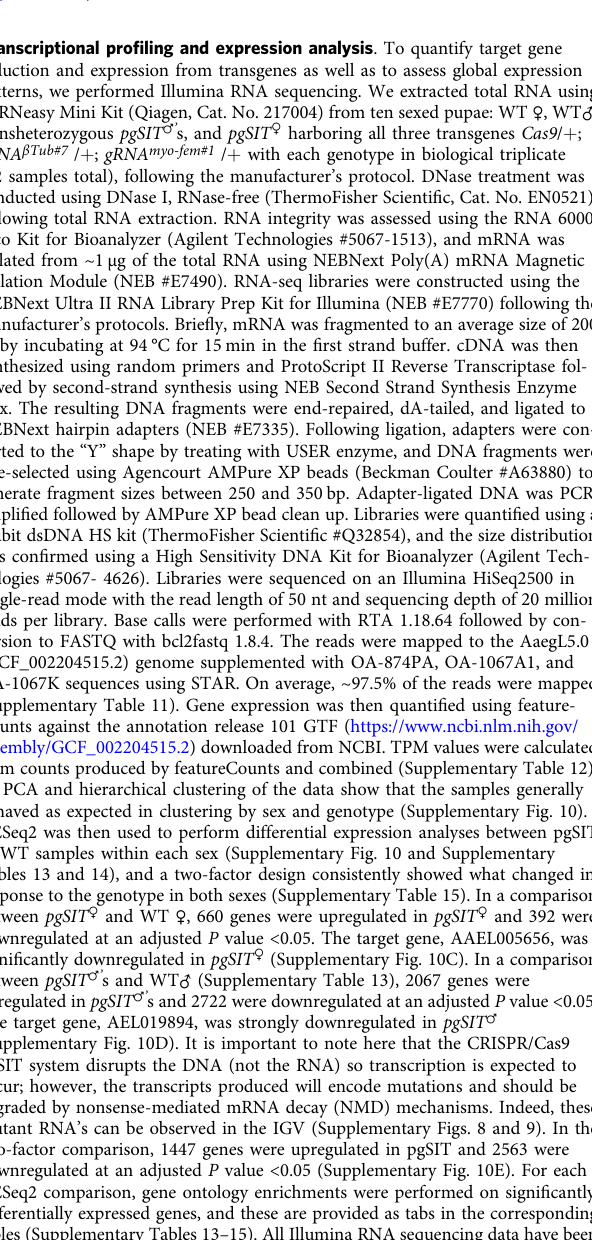
Life table parameters . Life table parameters were assessed by comparing WT, homozygous gRNA β Tub + myo-fem , homozygous Cas9 , and transheterozygous pgSIT ( gRNA β Tub + myo-fem / + ; Cas9 / + ) generated with Cas9 inherited from either the mother (maternal Cas9 ) or father (paternal Cas9 ). Larva/pupae development times were recorded as the number of days from hatched larvae to pupae and then to adults. One hundred larvae from each line were placed in separate larval rearing containers (Sterilite, 34.6× 21 ×12.4 cm, USA), each with 3 liters of deionized water, and fed once a day. Larvae were counted twice daily until pupation, and then the date of pupation and emergence were recorded. Larval to pupae development time was calculated for each sex. Pupae were transferred to plastic cups (Karat, C- KC9) with 100 ml of water, and survivors were recorded until adulthood. For measuring ♂ / ♀ longevity, we tested the variation in ♂ and ♀ longevity among different lines using two methods: (i) released along with WT of the opposite sex or (ii) without WT of the opposite sex. (i) One hundred WT, homozygous gRNA β Tub + myo-fem , homozygous Cas9 newly eclosed adult mosquitoes ( fi fty ♂ ’ s and fi fty ♀ ’ s) were maintained in a cage; fi fty newly eclosed pgSIT ♂ ’ s (maternal Cas9 ) and fi fty newly eclosed pgSIT ♂ ’ s (paternal Cas9 ) were caged with fi fty newly eclosed WT ♀ ’ s; and fi nally, fi fty newly eclosed pgSIT ♀ ’ s (maternal Cas9 ) and fi fty newly eclosed pgSIT ♀ ’ s (paternal Cas9 ) were caged with fi fty newly eclosed WT ♂ ’ s. (ii) Fifty ♂ ’ s or ♀ ’ s from each line were released into a cage separately without the opposite sex. Adults were provided with 10% sucrose and monitored daily for survival until all mosquitoes had died (three replicates). For measuring ♀ fecundity and fertility, ♀ ’ s ( n = 50) and ♂ ’ s ( n = 50) 3 days post emergence raised under the same standardized larval conditions were placed into a cage and allowed to mate for 2 days. ♀ mosquitoes were blood-fed until fully engorged and were individually transferred into plastic vials with oviposition substrate. Eggs were stored in the insectary for 4 days to allow full embryonic development and then were hatched in a vacuum chamber. Fecundity was calculated as the number of eggs laid per ♀ , and fertility was calculated as the percentage of eggs hatched per ♀